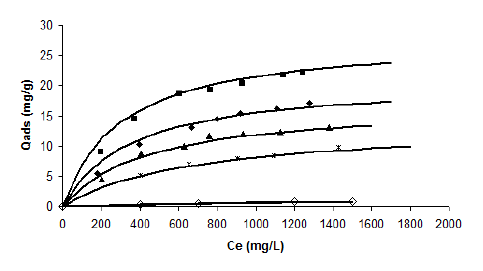
Figure 4. Adsorption isotherms of salicylic acid on -ØN-R20 [ ], -